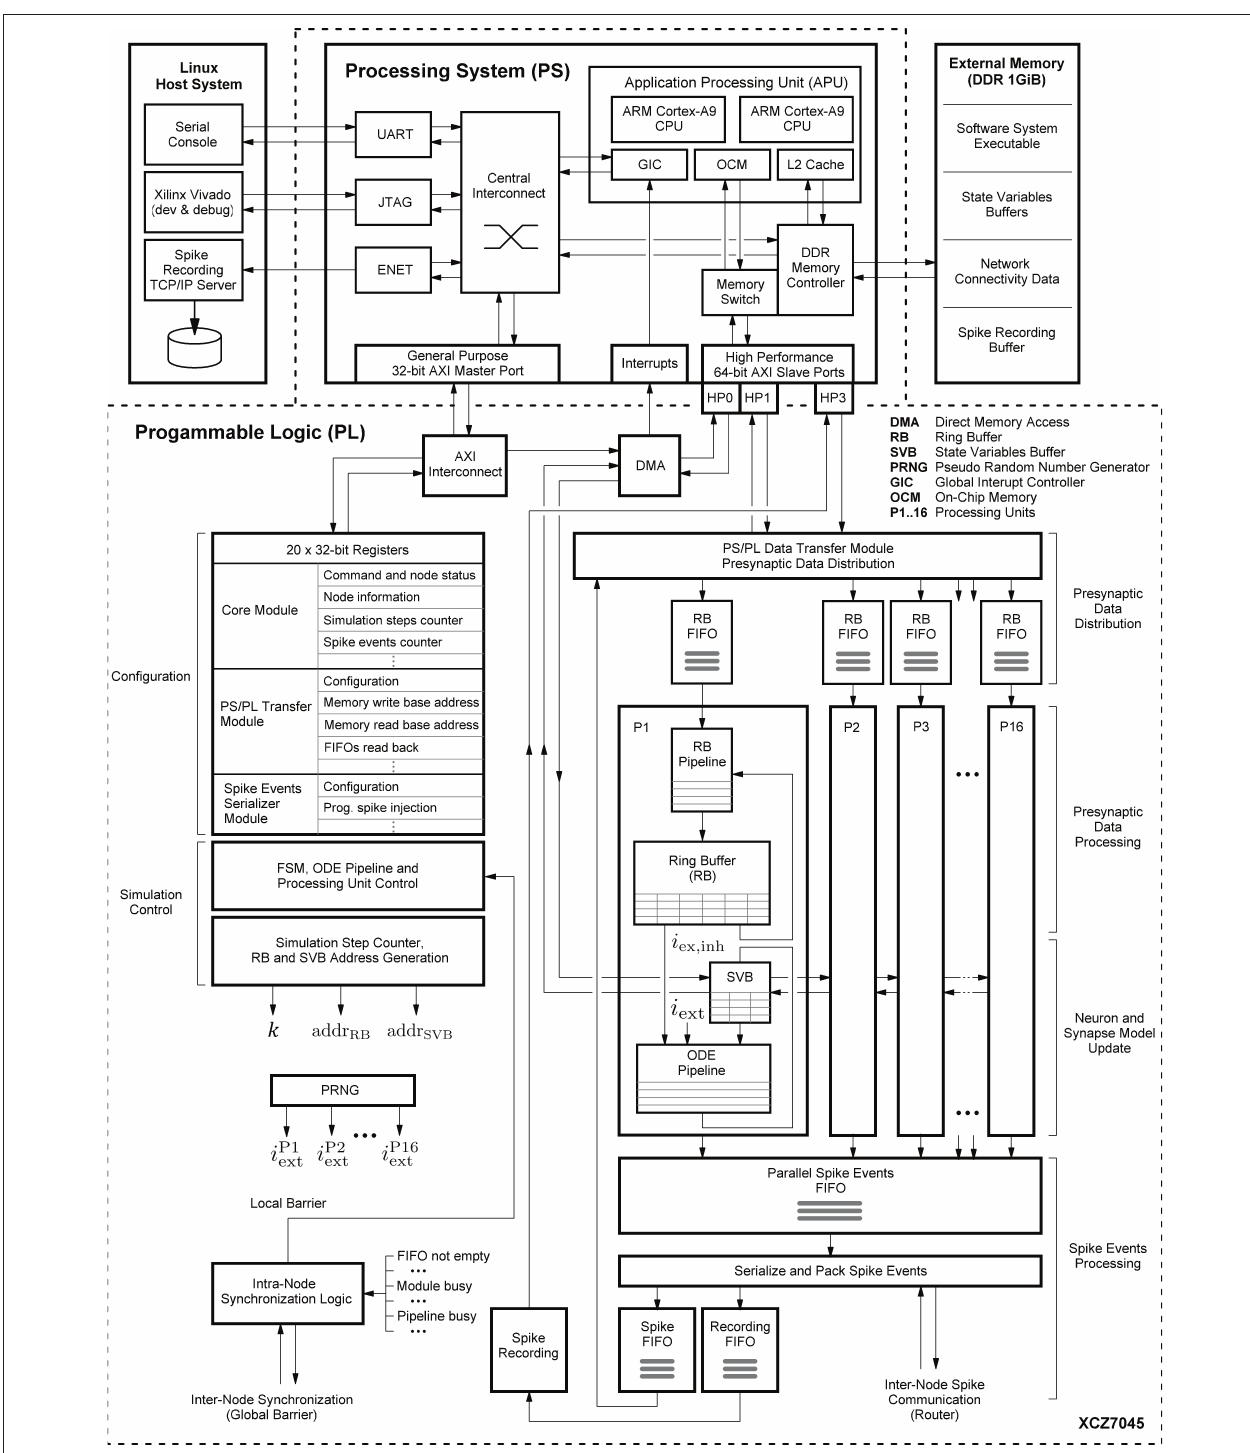
FIGURE 6 | System-level view of the HNC node hardware architecture. The on-chip components are framed by the dashed lines. The lower frame encloses all modules that have been implemented in programmable logic (PL), while in the upper frame the components of the processing system (PS) are shown. Attached to it is an external 1 GiB DDR RAM module (upper right). It stores the node software system executable and the data structures required for operation, for example, the state variables and connectivity information. The external memory also functions as buffer for the recorded spike data. The PS is further connected to a Linux host system (upper left) which provides a serial console to operate the HNC node, the Xilinx Vivado environment for development, and a TCP/IP server to collect the recorded binary spike data.